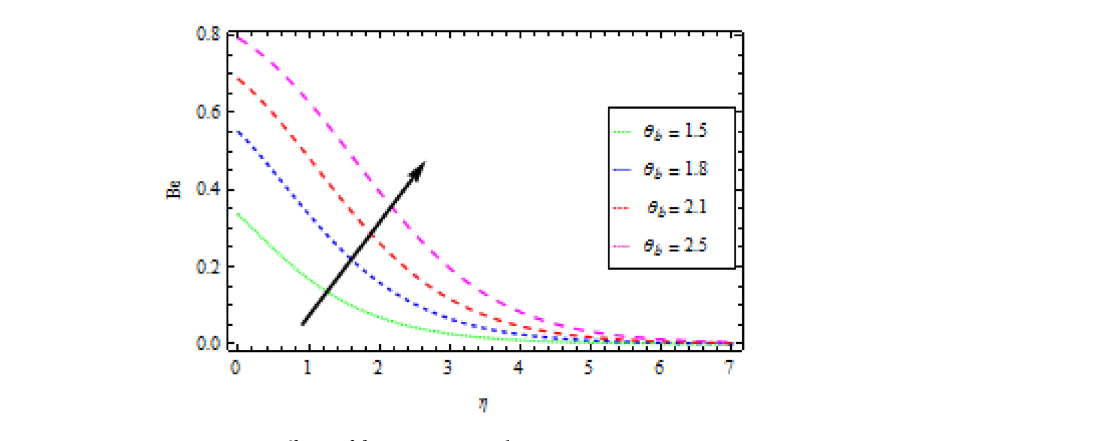
Figure 20. Effects of θ b on Bejan